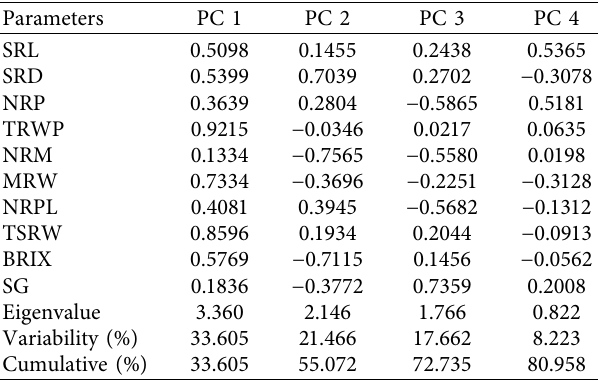
Table 6: Factor loadings, agronomic trait markers, contributed to variability in PFSP in